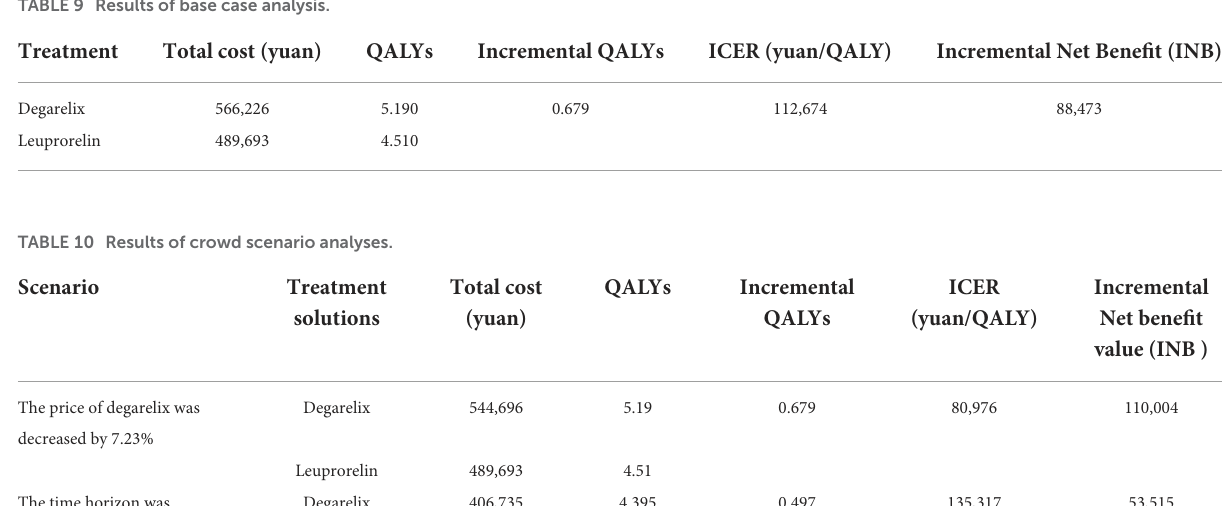
TABLE 9 Results of base case analysis.